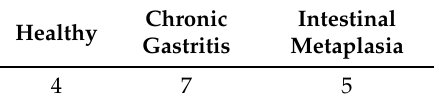
Table 1. Distribution of multispectral data according to histology.